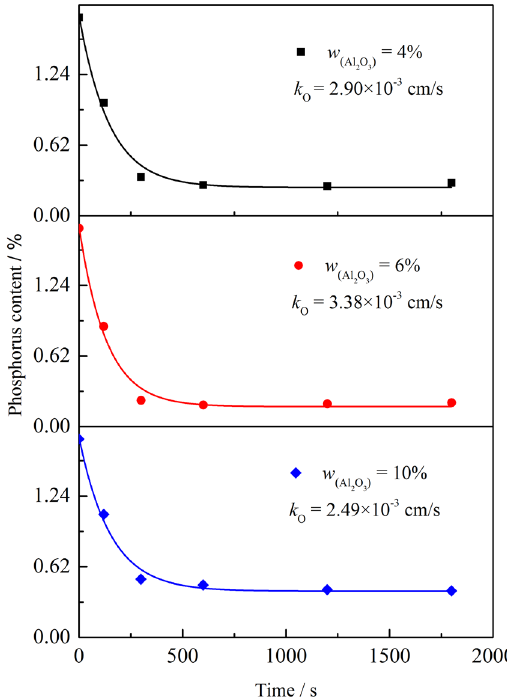
Figure 6: Variation of the P content as a function of time when the Al 2 O 3 content ranged from 4 to 10%.